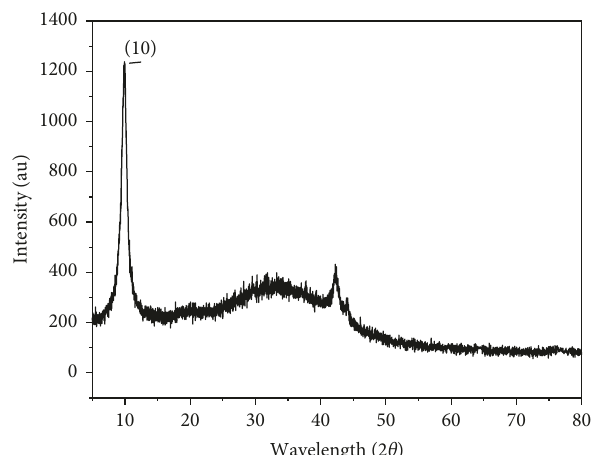
Figure 2: X-ray diffraction patterns of GO.